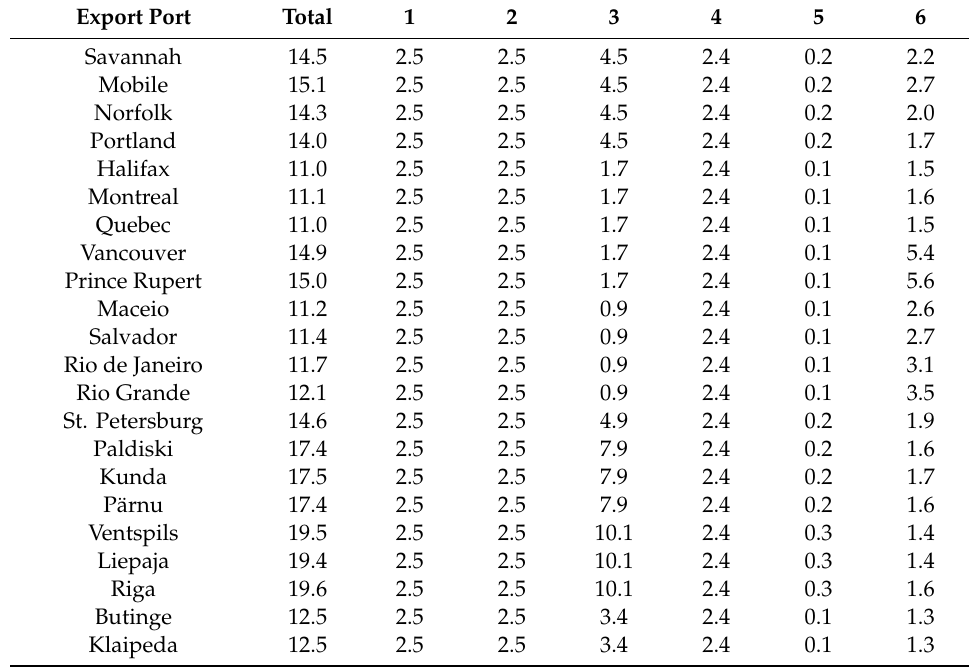
Table A15. Overview of supply chain GHG emissions of torrefied pellets produced from roundwood, transported over 500 km to export ports and including 50 km feedstock transport, in kg CO 2- eq / t pellets. Components included in the table: 1. Silviculture and harvest; 2. Feedstock transport; 3.